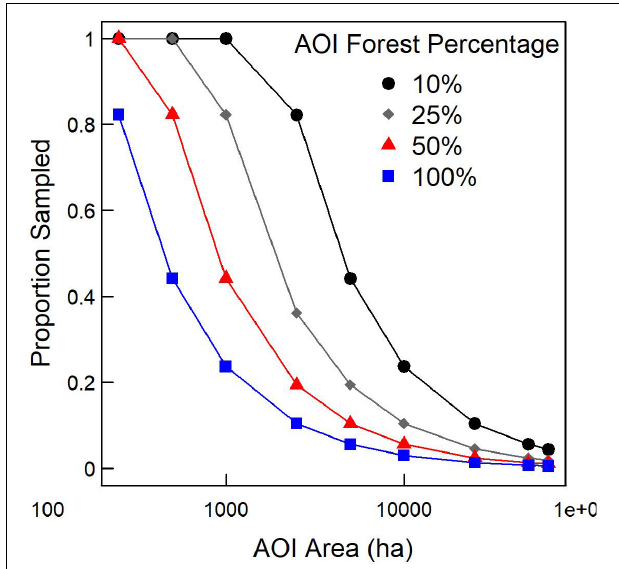
FIGURE 5 | Proportion of pixels sampled for AOIs of differing sizes and forest extent to, on average, generate variance estimates within 1% of the variance estimate using all pixels.